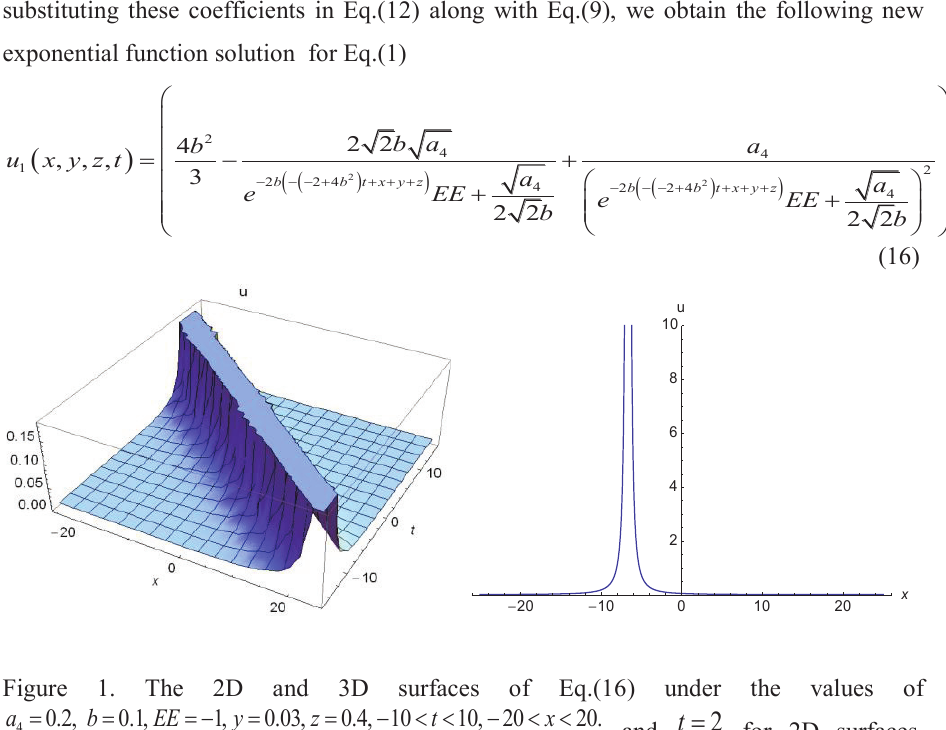
Figure 1. The 2D and 3D surfaces of Eq.(16) under the values